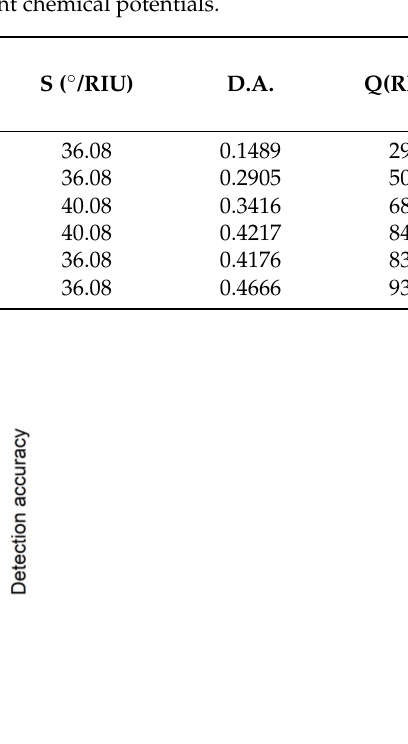
Figure 9. Comparison of the quality factor and detection accuracy of the proposed sensor at different chemical